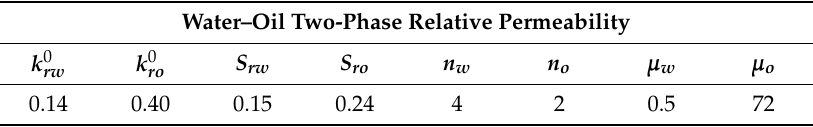
Table 2. Corey model parameters for water–oil two-phase relative